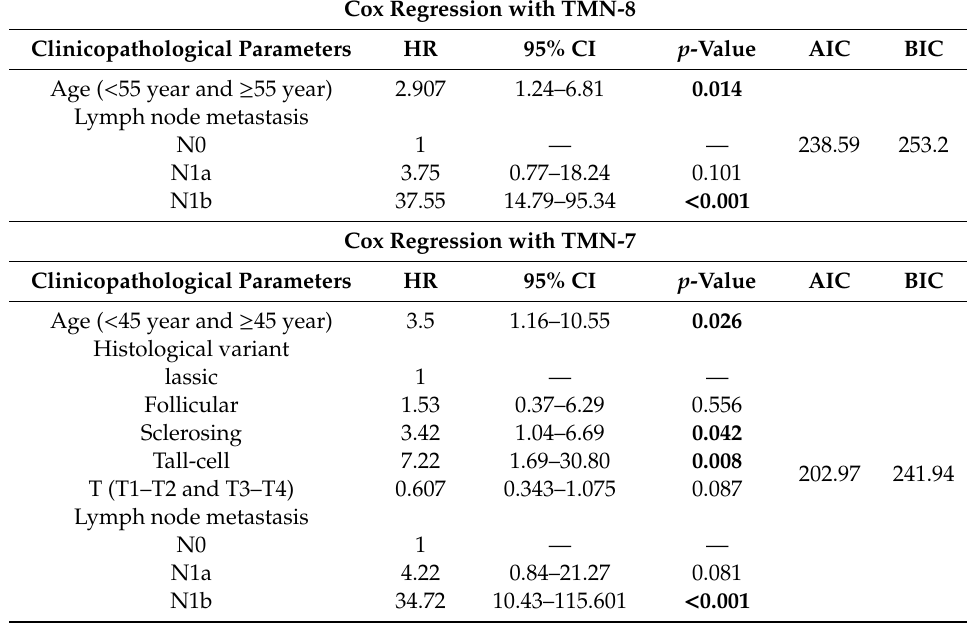
Table 3. Cox regression for the prediction of DFI performed with stage-determining factors and other clinicopathological parameters. The table shows predictors retained in the model after backward selection. The variables entered in the model were: gender, histological variants, AITD, multifocality, dichotomized age, T, N, muscle and vascular invasion. HR: hazard ratio. CI: confidence interval. AIC: Akaike information criterion. BIC: Bayesian information criterion. p -values < 0.05 are evidenced in